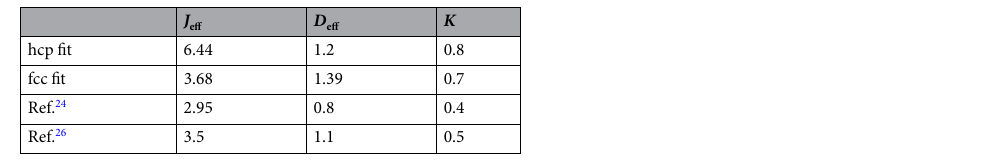
Table 2. Parameters of the effective NN exchange model obtained by fitting the DFT results for hcp-Pd/Fe/ Ir(111) and fcc-Pd/Fe/Ir(111) and values from the literature. For hcp D eff has been chosen as the NN DFT value (cf. Table 1). Sign convention as in Table 1. The coefficients are given in